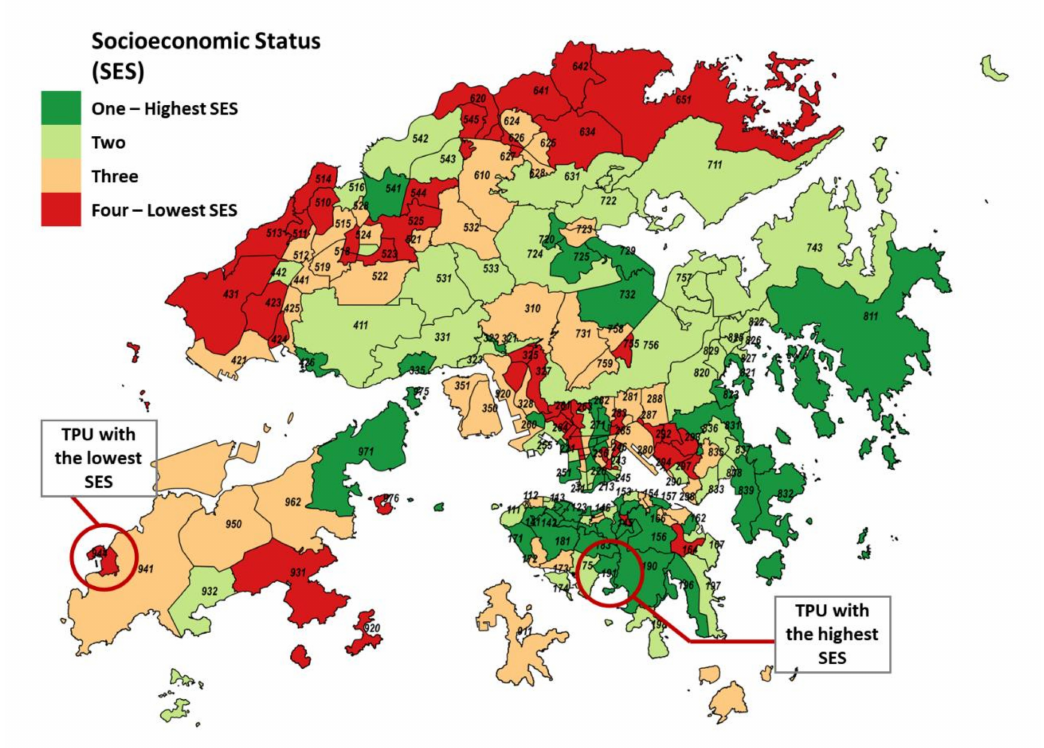
Figure 1. The geographical distribution of socioeconomic status (SES) groups by median monthly household income of tertiary planning units (TPUs) in Hong Kong, where One = highest SES, shown in green and Four = lowest SES, shown in